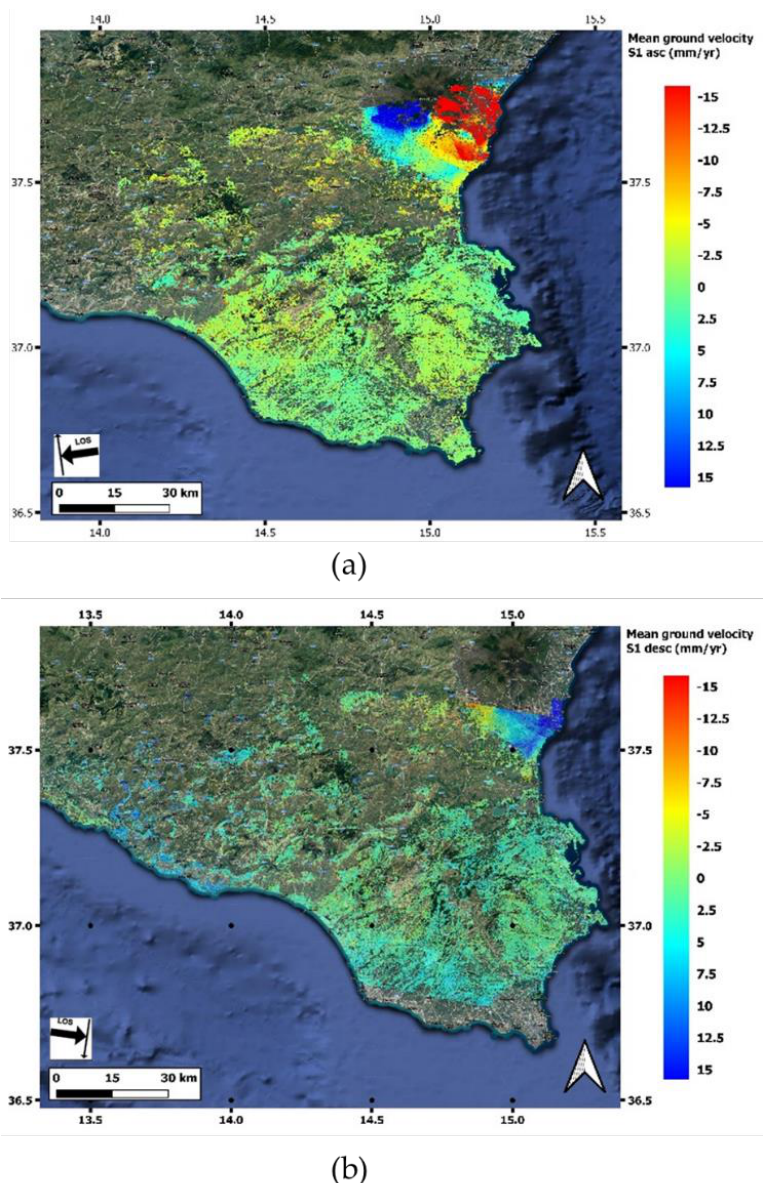
Figure 3. Land velocities (mm/year) estimated in the time span 2015–2020 from InSAR for ( a ) ascending and ( b ) descending orbits. The marked surface deformation observed in the northern part of the area is related to the effects of the volcanic and seismic activity occurred on Etna in December 2018.